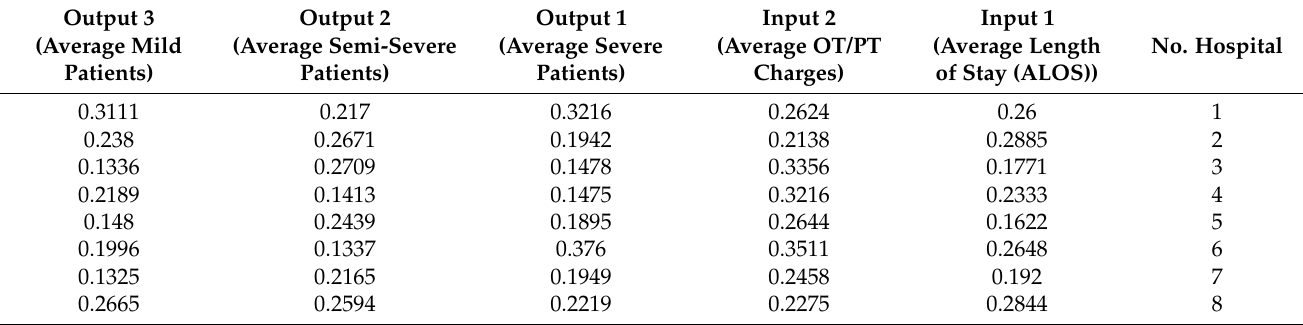
Table 3. The normalised data of the